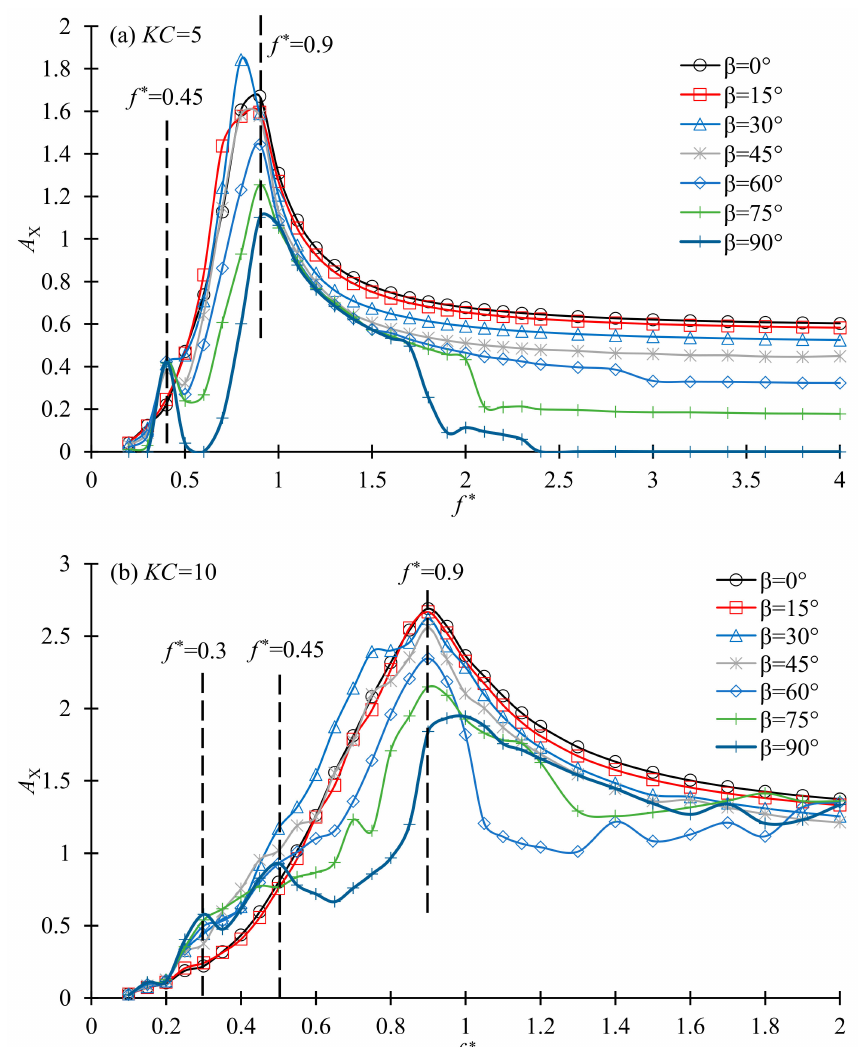
Figure 13. Variation in the vibration amplitude with the frequency